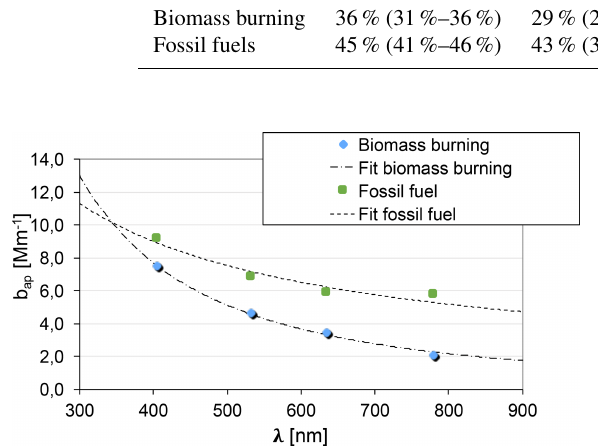
Figure 7. b ap -to-EC ratio dependence on λ for biomass burning and fossil fuel emissions. Error bars represent the 25th and 75th percentiles retrieved from the bootstrap